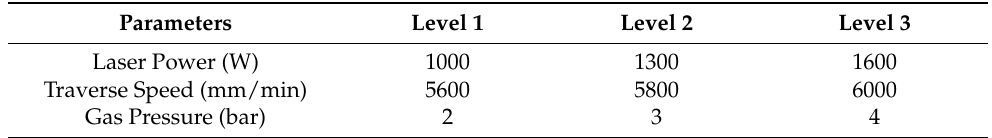
Table 2. Input parameters values for specimen thickness of 4 mm. FTC: 1000 W laser power, 6080 mm/min traverse speed, and 2 bar gas pressure.